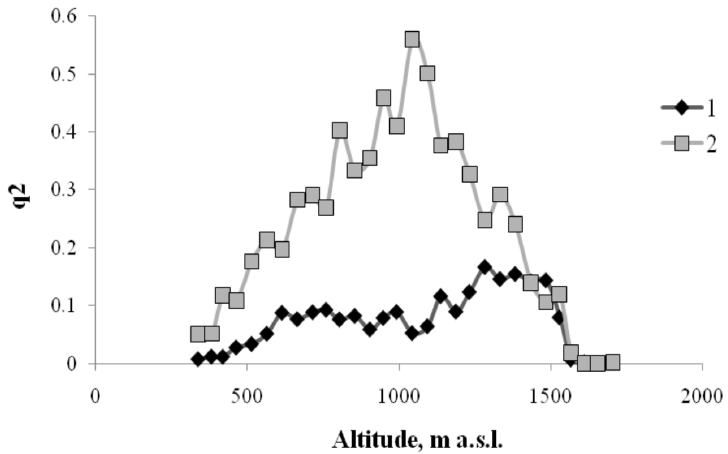
Figure 7. Height ‐ related changes in the values of squared order parameter, q 2 , for the Siberian fir and Siberian pine (1—Siberian pine; 2—fir; order parameters—fractions of the area at heights H occupied by the trees of these species).